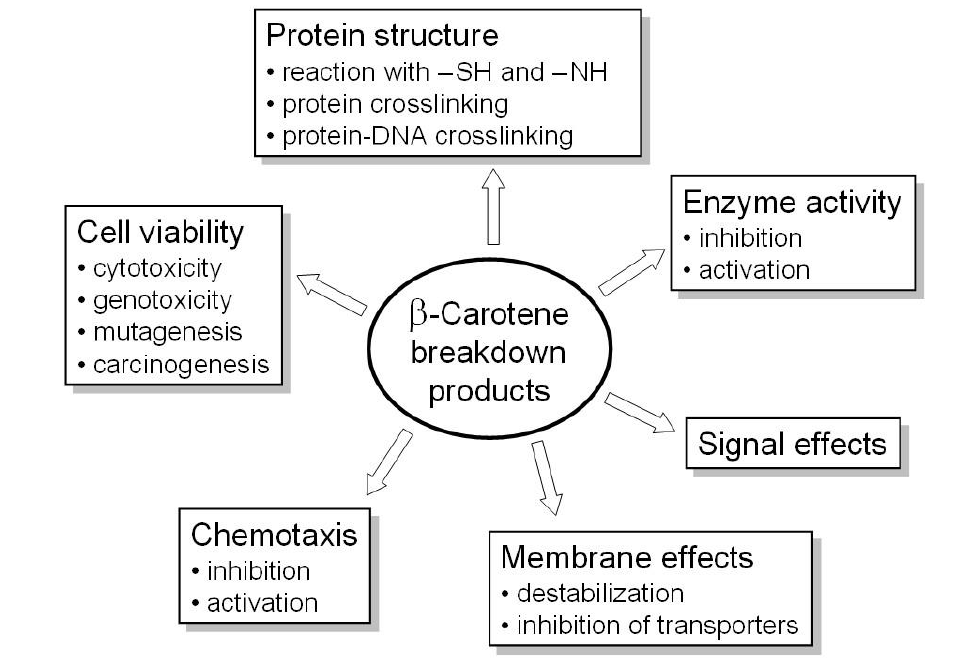
Figure 3. Overview of the biological effects of β -carotene breakdown